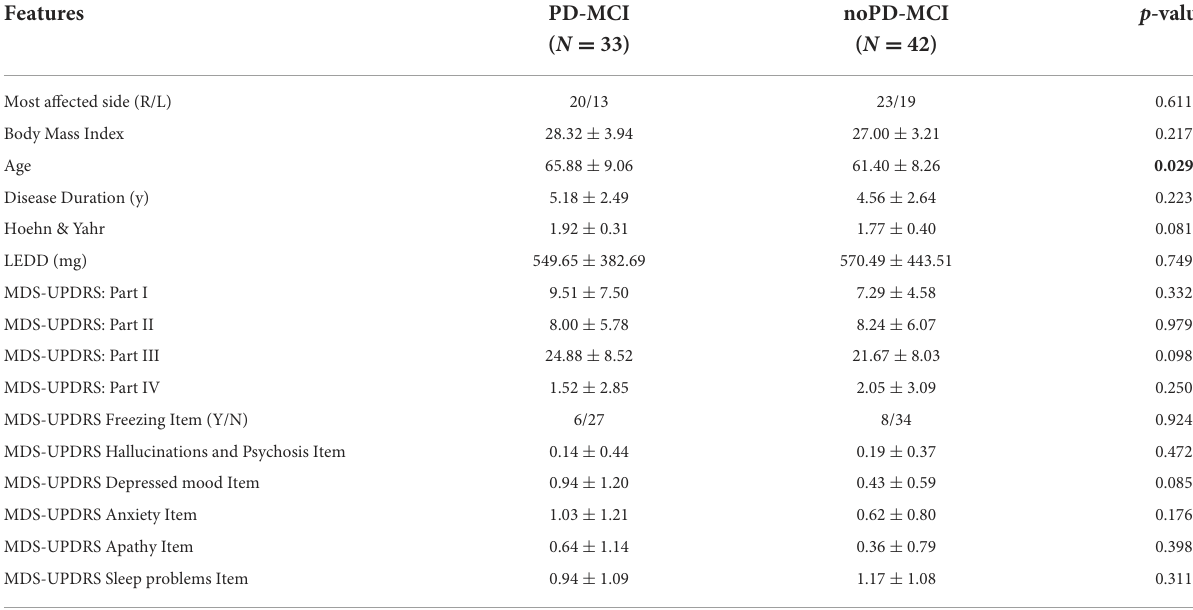
TABLE 1 Comparison of demographic and clinical features between PD-MCI and